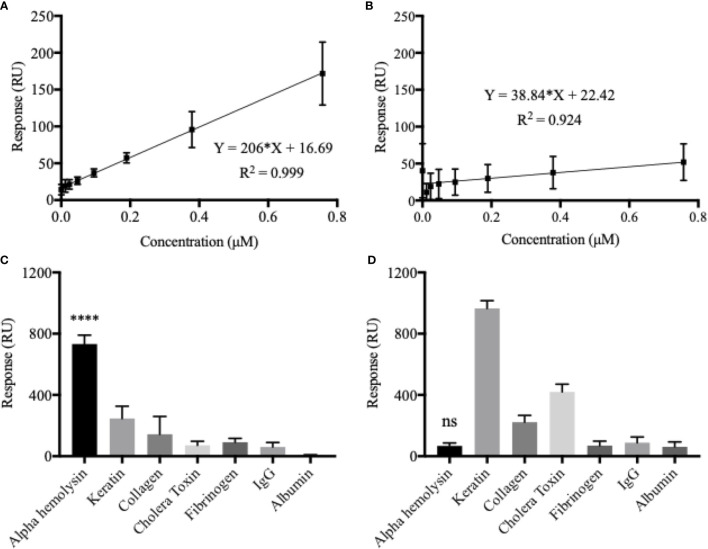
Chip sensitivity and selectivity is heavily dependent on the formation of template-molecular imprints. Calibration curves were established using an α-hemolysin dilution series of 0.012–0.76 µM. The molecular imprinted polymer (MIP) (A) yielded a considerably higher response and showed a much broader dynamic range as compared to the non-imprinted polymer (NIP) (B). The MIP essentially demonstrated a double binding response (RU) for every doubling in α-hemolysin concentrations. Although some unspecific binding, low for potential blood-sample contaminants but higher for potential skin-swab contaminants, could be detected, the MIP proved to be highly selective for α-hemolysin (C). The NIP showed no α-hemolysin selectivity (D). All presented values represent the mean of triplicates with corresponding SD values. One-way ANOVA analysis was used to evaluate selectivity results (C, D). ****P < 0.0001; ns, non-significant.